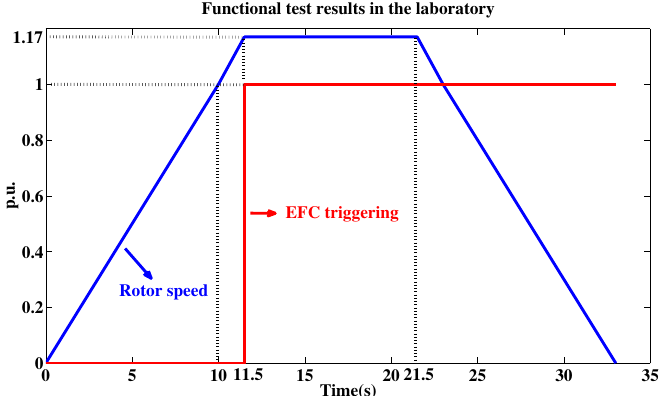
Figure 16. Functional test results of the new OPC module in the laboratory. On the y -axis, a value of 1